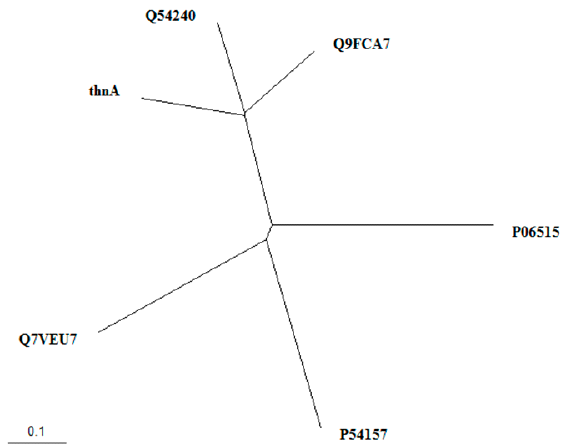
Figure 4. Phylogenetic analysis of bacterial type III PKS related to thnA using Clustal Omega and visualized as unrooted trees by TreeView. 1, 3, 6, 8-tetrahydroxynaphthalene synthase (THNS) from different strains, thnA : Nocardia sp. CS682, Q9FCA7: Streptomyces coelicolor A3(2) and Q54240: Streptomyces griseus ; Chalcone synthase from different strains, P54157: Bacillus subtilis subsp. subtilis str. 168 and P06515: Antirrhinum majus ; Alpha-pyrone synthase, Q7VEU7: Mycobacterium tuberculosis.